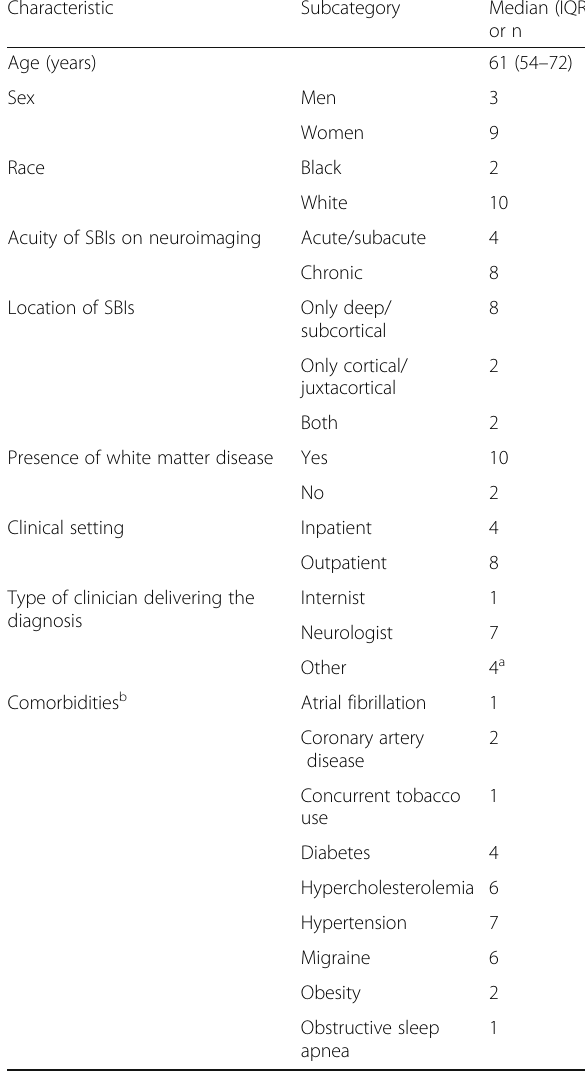
Table 1 Characteristics of patient participants